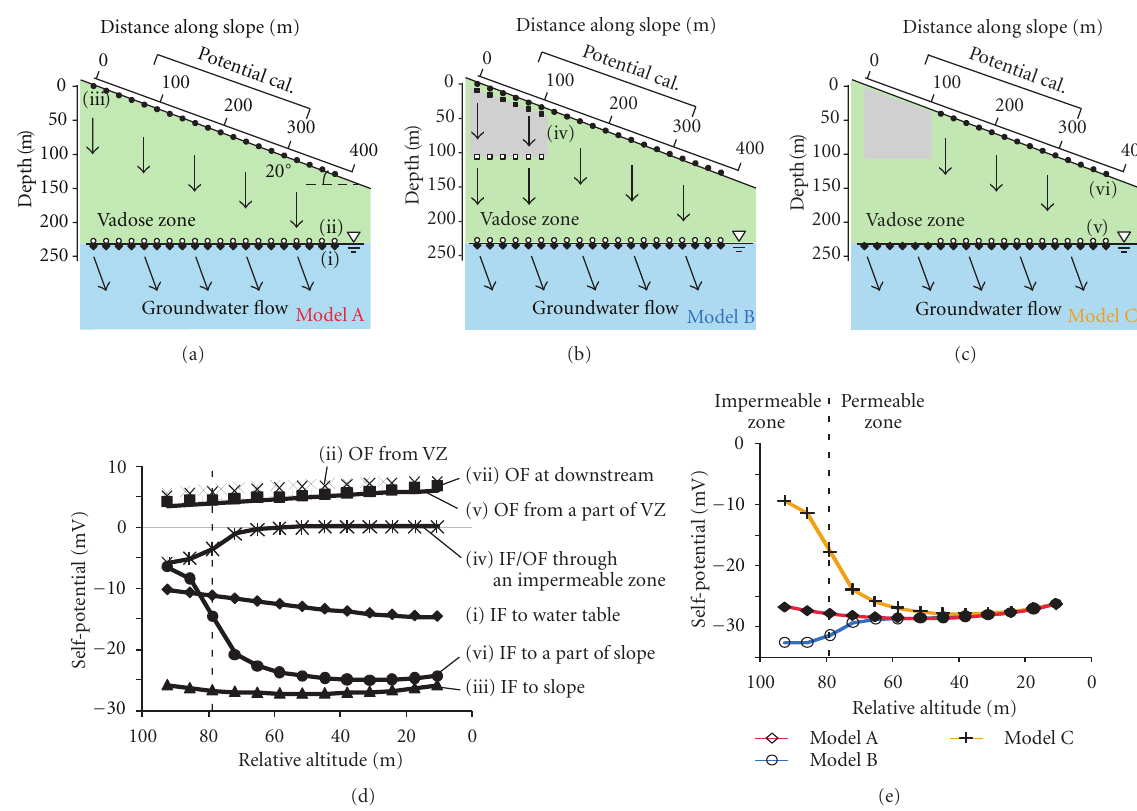
Figure 8: Numerical modeling of SP profiles along slopes. (a) Model A with homogeneous subsurface structure. (b) Model B with constant infiltration through both a less permeable zone (gray) and surroundings. (c) Model C with heterogeneous infiltration outside of an impermeable zone (gray). In all three models, diamonds, circles, and rectangular dots indicate electric current sources with intensity of 0.004, 0.002, and 0.001 A, respectively. Solid and open symbols mean negative and positive polarities, respectively. Arrows indicate assumed flow directions. SP profiles shown in (d) and (e) are calculated along the thick line portion on the slope for each case. (d) Calculated SP from respective current sources. The abbreviations are as follows: IF: inflow, OF: outflow, and VZ: vadose zone. (e) Resultant SP profiles from three models against